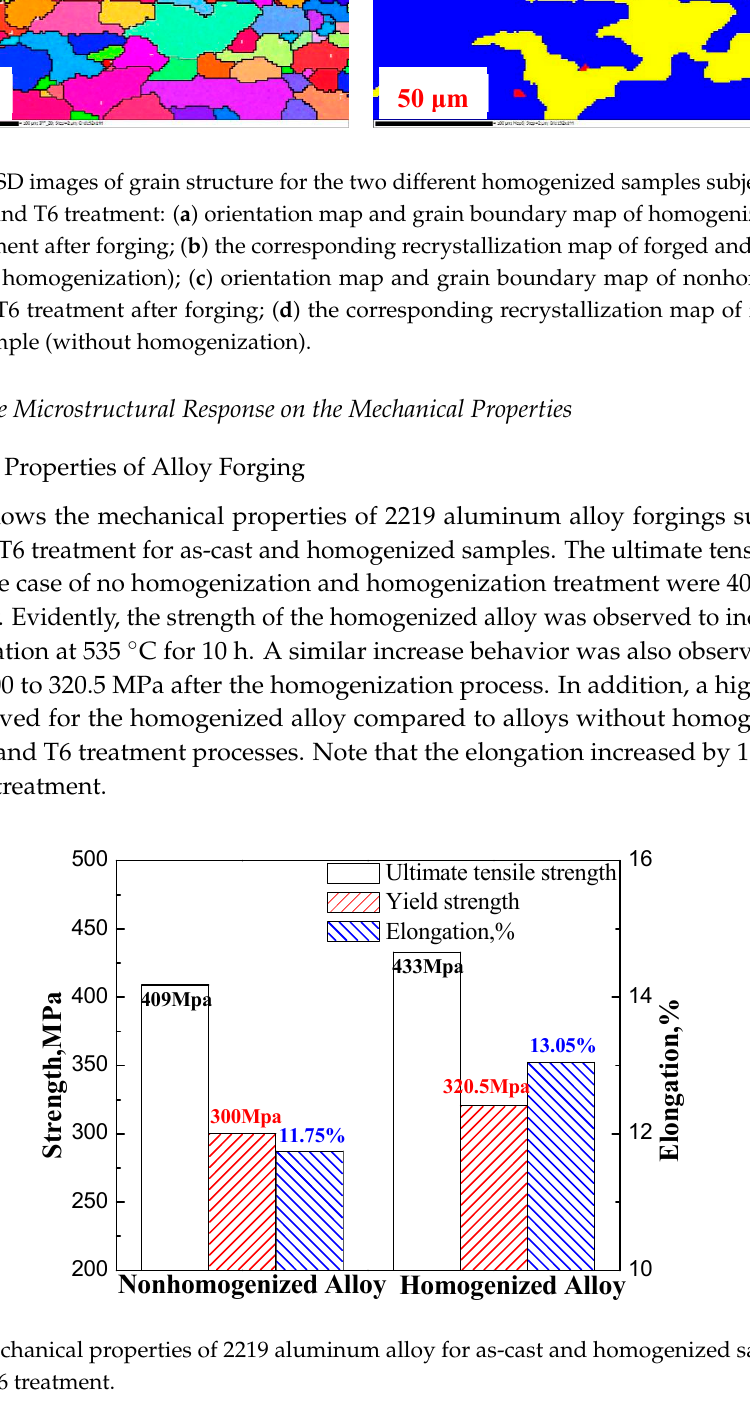
Figure 13. Mechanical properties of 2219 aluminum alloy for as-cast and homogenized sample after forging and T6 treatment.